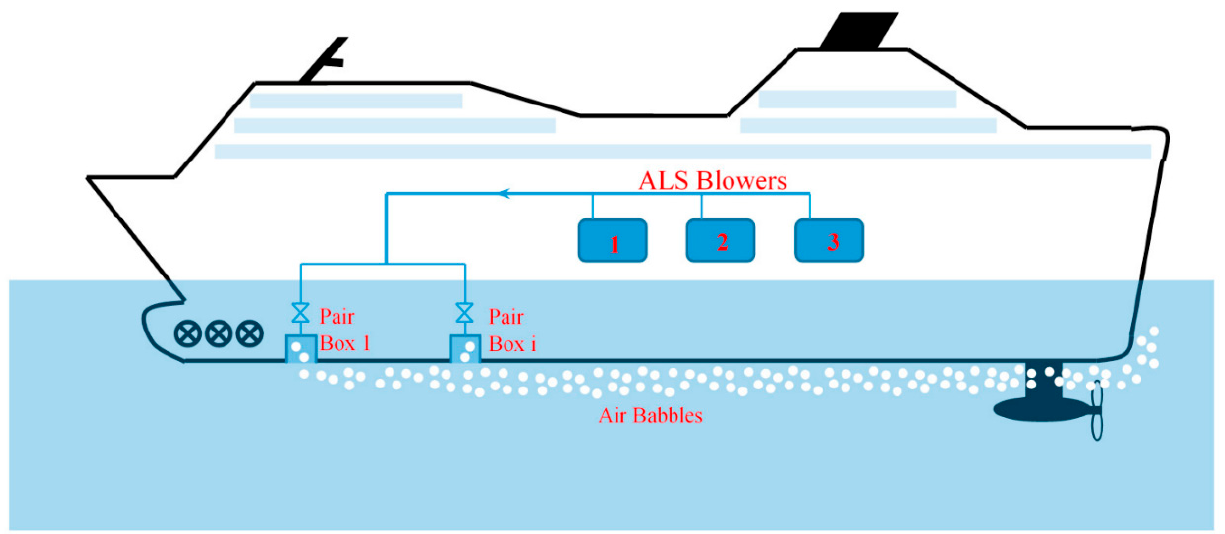
Figure 4. Diagram of ALS system producing air layer under the hull bottom of a passenger vessel. Reproduced from [132], with permission from MDPI, 2021.